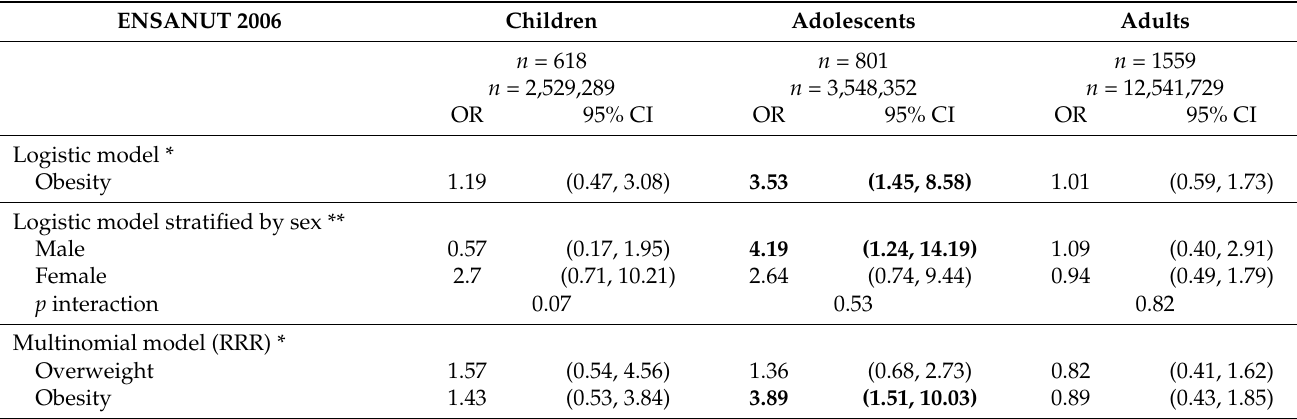
Table 2. Association between past year PM 2.5 (10 µ g/m 3 increase) with obesity in children, adolescents, and adults from the Greater Mexico City Area using data from the 2006 National Nutrition and Health Survey, ENSANUT